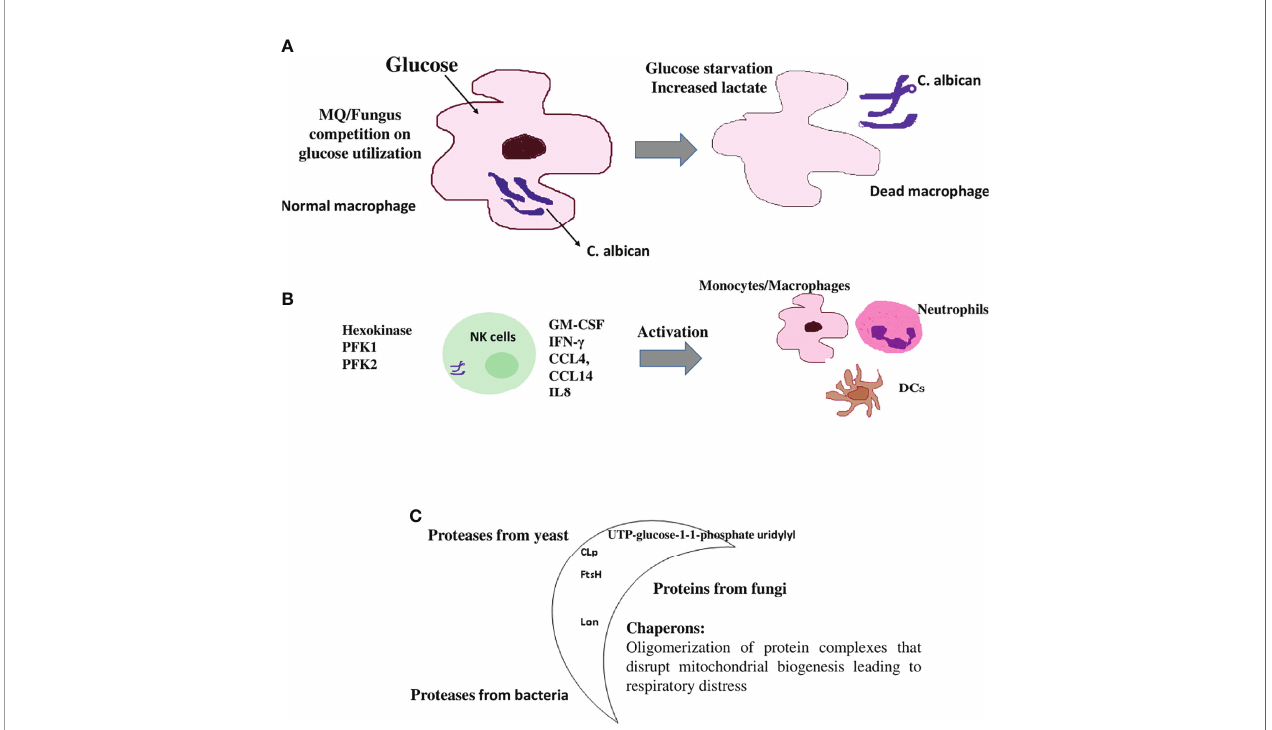
FIGURE 3 | Immunometabolic changes in immune cells upon fungal and parasitic infection (A) MQs are metabolically in fl exible and depend on glucose as a carbon source. The discussed Candida albicans fungus switches from yeast to fi lamentous hyphae, once taken by MQs. Fungal hyphae reactivate glycolysis and compete with MQs for glucose, which leads to depletion of glucose available to this immune cell by the fungus. MQ is killed by glucose starvation (56). High glycolysis is a metabolic shift in MQs during C. albicans infection. High glycolysis also results in increased lactate (Warburg-effect metabolism status) that is also utilized by C. albicans . (B) Natural killer (NK) cells respond to C. albicans pathogenII with the upregulation of genes involved in immune signaling and release of in fl ammatory cytokines that are involved in the activation of other immune cells as well as a shift to aerobic glycolysis. These include IFN- g , GM-CSF, CCL4 (MIP-1 b ), IL8 (involved in the recruitment and activation of neutrophils), CCL14 (monocytes activator), XCL1 (dendritic cells activator), and the glycolytic enzymes hexokinase 2, phosphofructokinase1 (PFK1), phosphofructokinase fructose-2,6-bisphosphate (PFK2), and lactatedehydrogenase. (C) The moonlighting proteins: multifunctional proteins act as chaperones and are widely involved during the pathogenesis of infection through cell surface presentation. Some pathogenic bioactive metabolites are immune modulators and have been implicated in suppressing the host immune response. For example, in bacteria, the production of FtsH and CLp proteases, which are responsible for infectivity and virulence of a number of bacterial pathogens. In C. albicans , UTP-glucose-1-1-phosphate uridylyl transferase, an enzyme involved in cell wall glycans biosynthesis, has been detected at the cell surface of this fungus and shows immune cell modulation. In helminths and protozoan parasites, the synthesis of glycoconjugates and glycan-binding proteins such as the mitochondrial Lon protease are examples of these immune